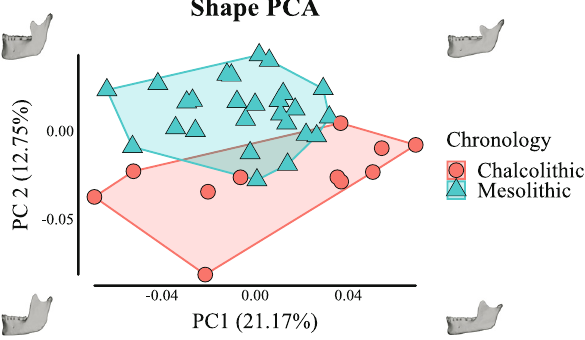
Figure 3: PCA of shape variation of Mesolithic hunter – gatherer and Chalcolithic agro - pastoralist mandibles.